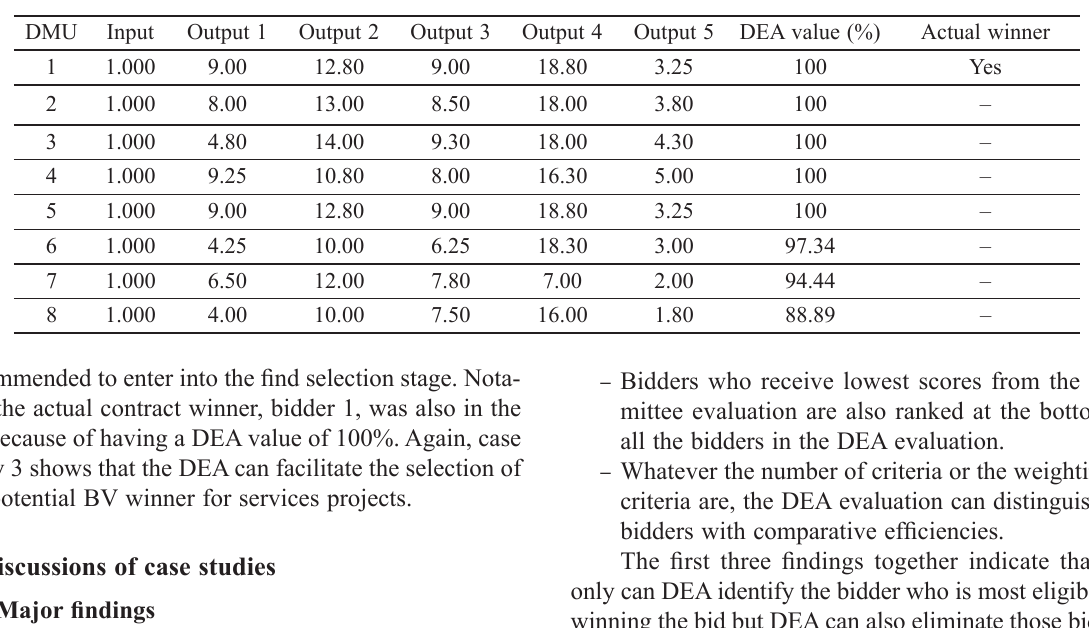
Table 6. DEA evaluation results of case project